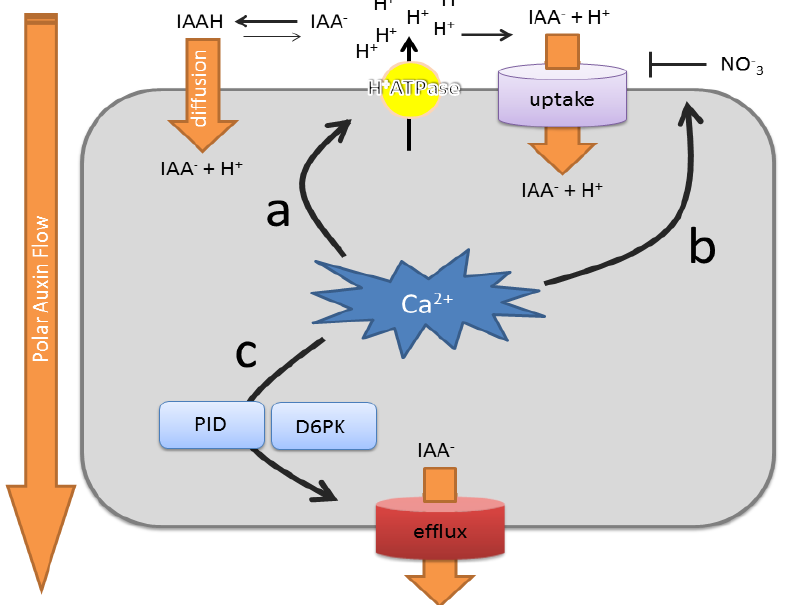
Figure 3. Summary of the effects of Ca 2+ on polar auxin transport rates. ( a ) Cellular Ca 2+ signaling impacts on auxin uptake mechanisms via effects on the abundance and activity